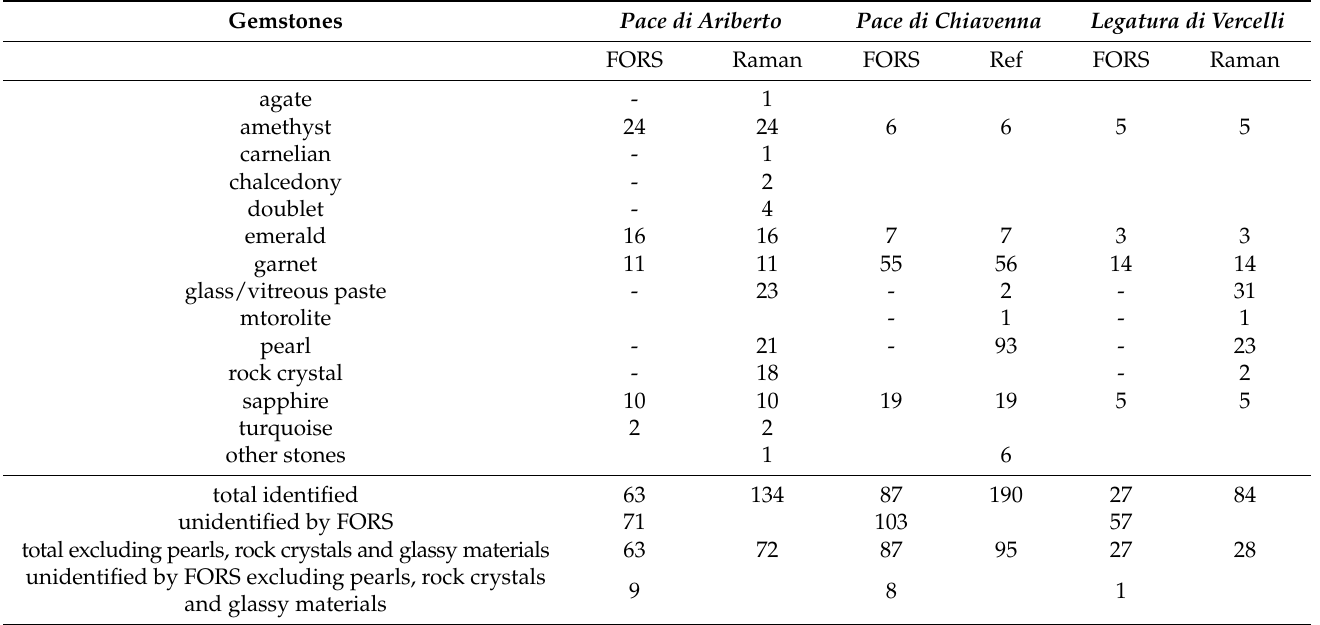
Table 1. Comparison of the results obtained with FORS, Raman spectroscopy and refractometry (Ref) in the analysis of three precious